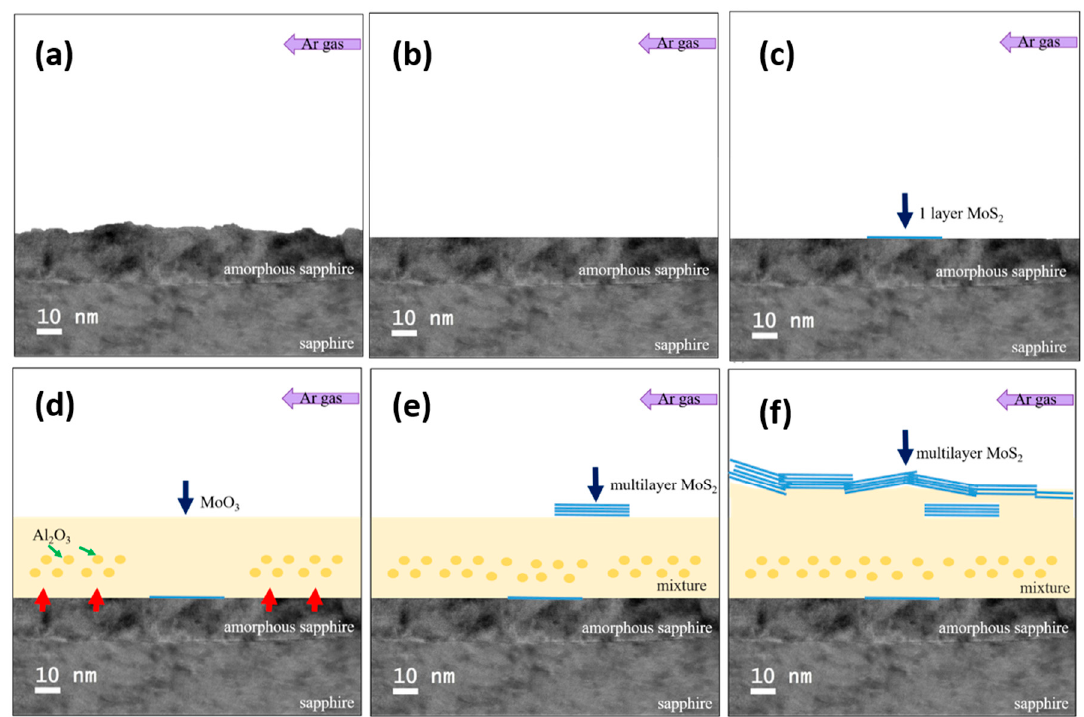
Figure 9. Schematic of the MoS 2 growth process. The purple arrow in the figure is the direction of argon ventilation, and the blue line segment represents a single layer of MoS 2 . The light yellow area represents the mixed zone dominated by MoO 3 , the dark yellow dot is amorphous Al 2 O 3 mixed in the reflection, and the blue line segment is superimposed to represent multilayer MoS 2.